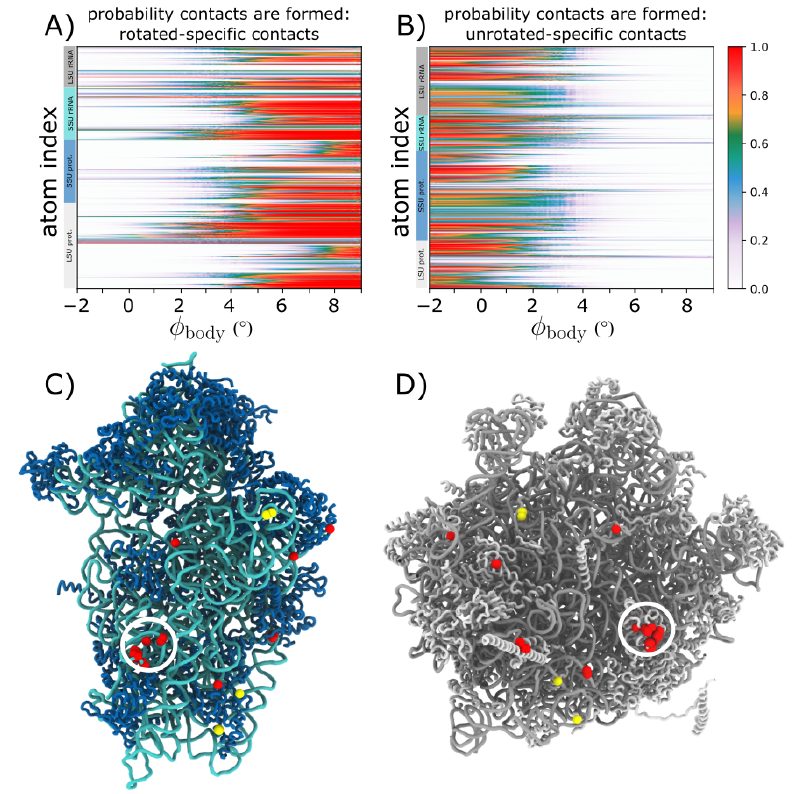
Figure 4. Contact analysis reveals sequential displacements at the SSU-LSU interface. ( A ) Average fraction of rotated-specific inter-subunit contacts formed, by atom, as a function of φ body . Many rotated-specific contacts are formed by the time the ribosome reaches the TSE ( φ body ∼ 3.5 ◦ ). Contact probabilities for each simulation may be found in Figure S2. ( B ) In contrast to the rotated-specific contacts (panel A), the unrotated-specific contacts are rarely formed in the TSE. ( C ) Structure of the SSU, viewed from the SSU-LSU interface. Red (yellow) spheres indicate which atoms have at least one rotated-specific (unrotated-specific) contact formed in more than 80% of the TSE frames. ( D ) Structure of the LSU, viewed from the SSU-LSU interface, shown in the same representation as in panel C. While there are only four atoms involved in unrotated contacts in the TSE (yellow), there are clear clusters of rotated contacts formed in the TSE (red). In particular, contacts between h14 and protein L23 (also called uL14, found in bridge B8; circled) are frequently formed, indicating they can have a strong influence on the free-energy barrier and kinetics of